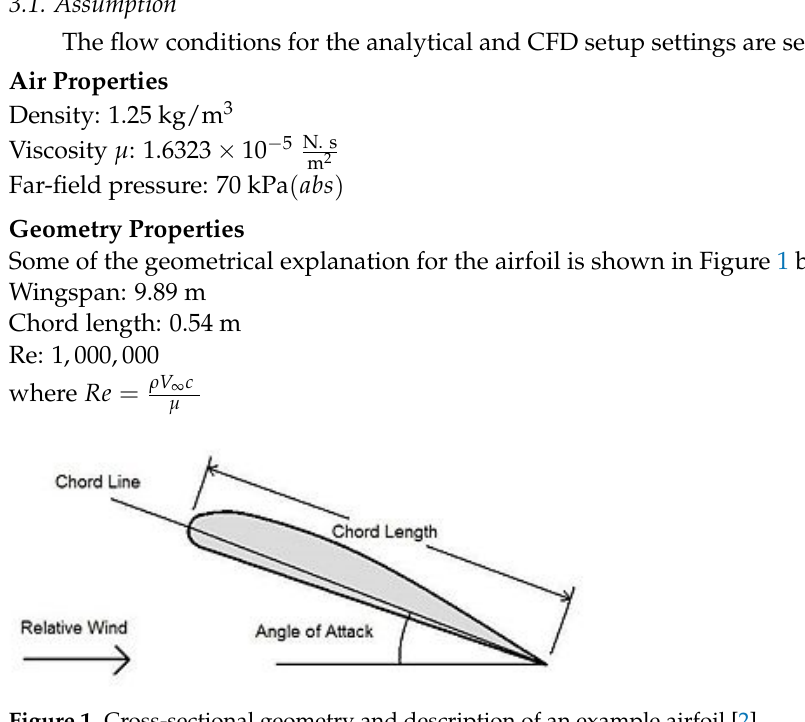
Figure 1. Cross-sectional geometry and description of an example airfoil [2].